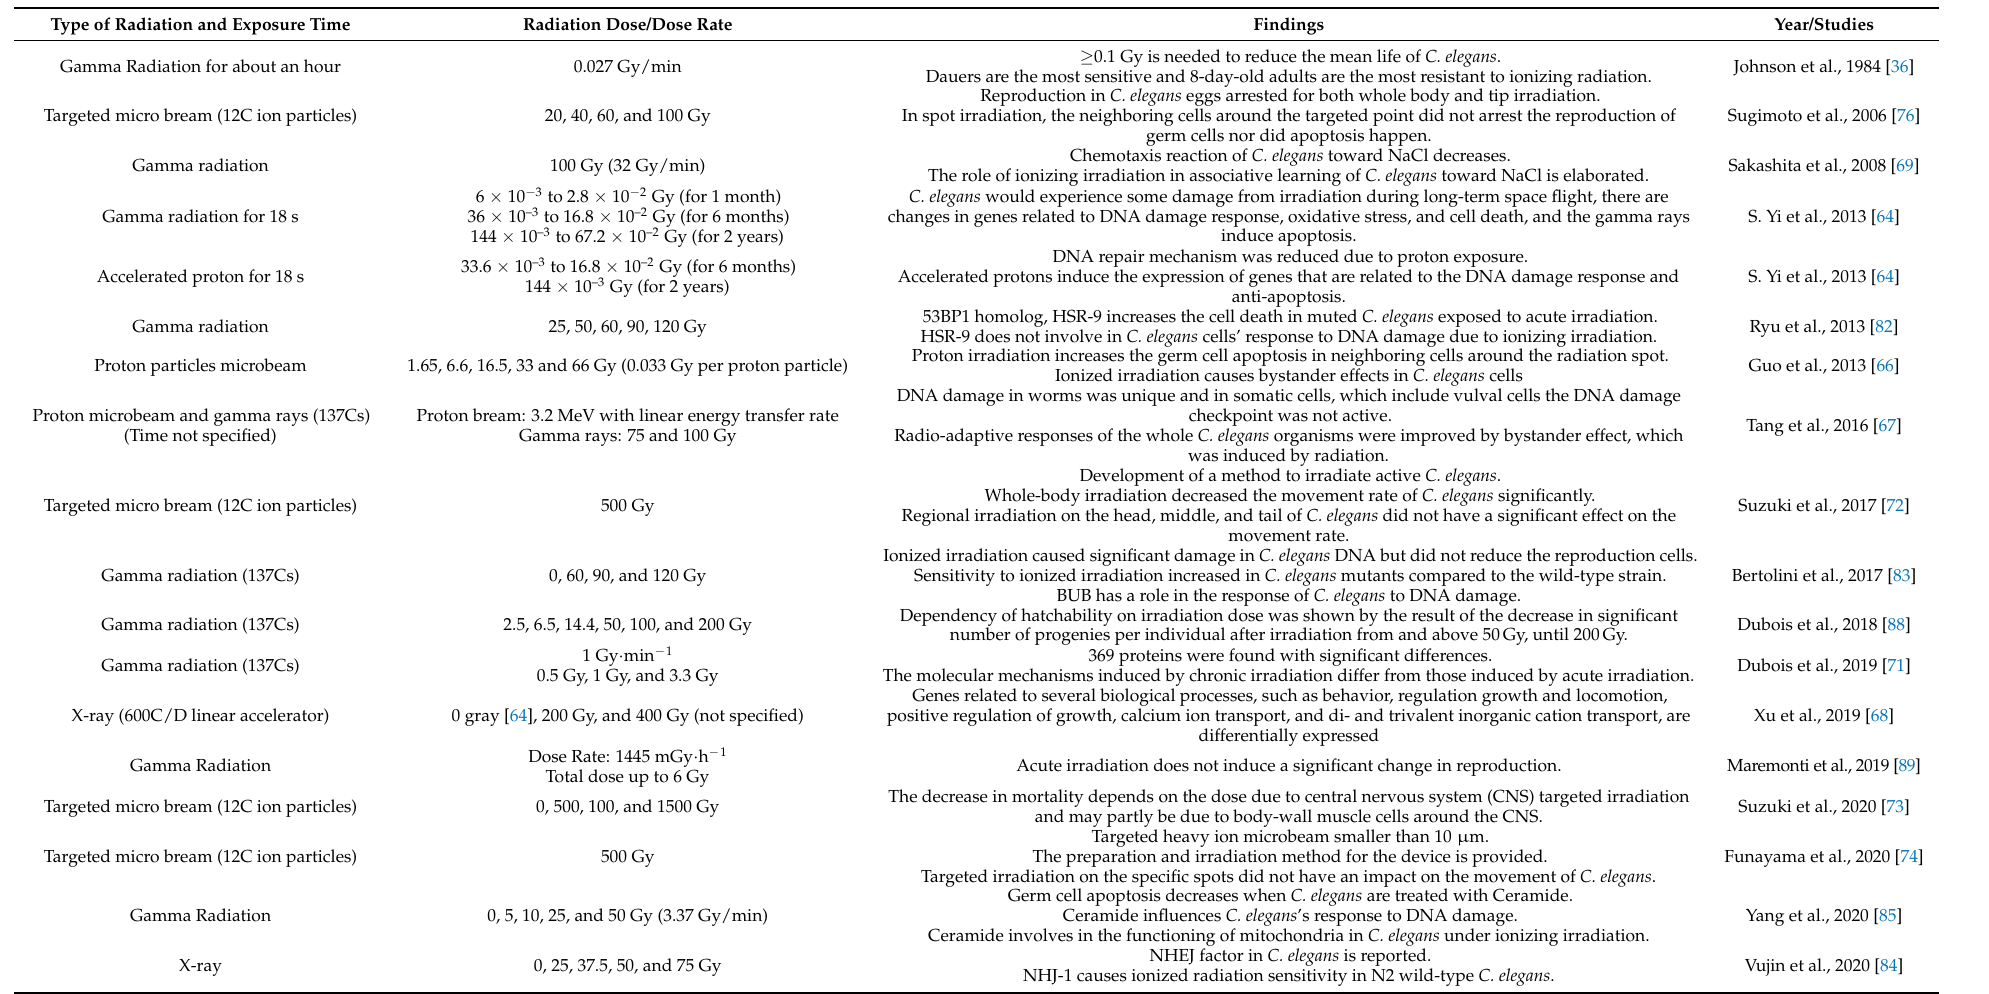
Table 1. Summary of Acute Irradiation of C. elegans